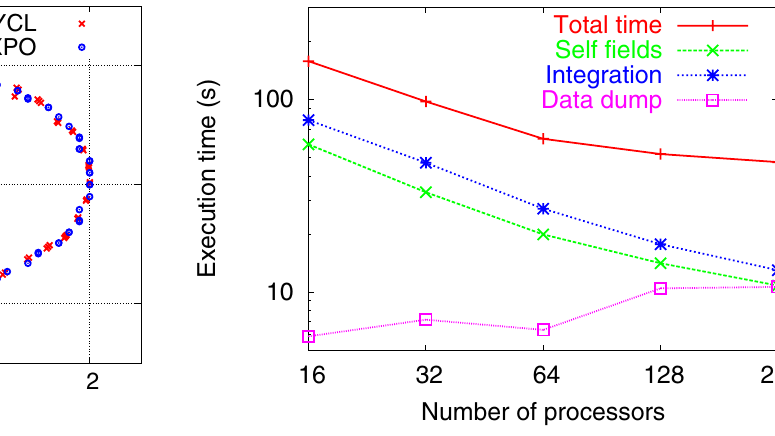
FIG. 4. (Color) Radial eigenellipse of 2 MeV at the symmetric line of a magnet in the injector II